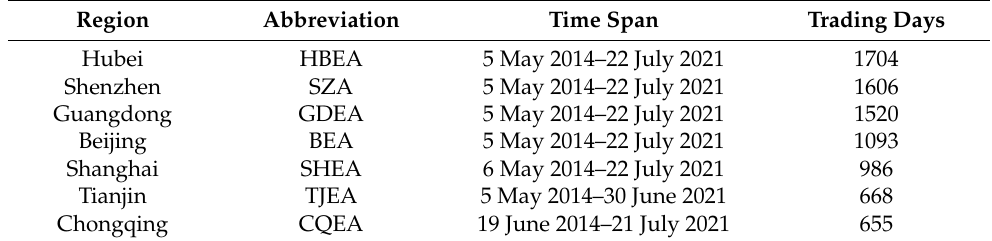
Table 1. The trading situation of the carbon trading markets from 5 May 2014 to 22 July 2021. Region Abbreviation Time Span Trading Days Hubei HBEA Shenzhen SZA Guangdong